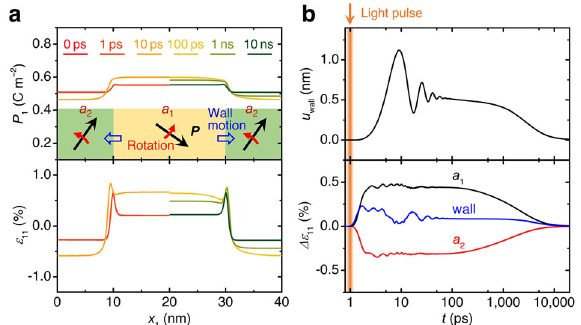
Fig. 6 Structural dynamics in 90° domains with tilted domain walls. a Spatial distribution of initial and excited-state polarization P 1 and strain ε 11 at selected times. Both fi elds are symmetric about x 1 = 20 nm. For clarity, we only show the x 1 < 20 nm half of the data at t (cid:6) 10 ps and x 1 > 20 nm half of the data at t > 10 ps . The top panel contains a schematic showing polarization rotation of each domain and motion of domain walls. b Temporal evolution of the domain wall displacement u wall as well as light-induced strain change Δ ε 11 inside a 1 and a 2 domains and at the center of domain walls. Corresponding polarization evolution is shown in Supple- mentary Fig.